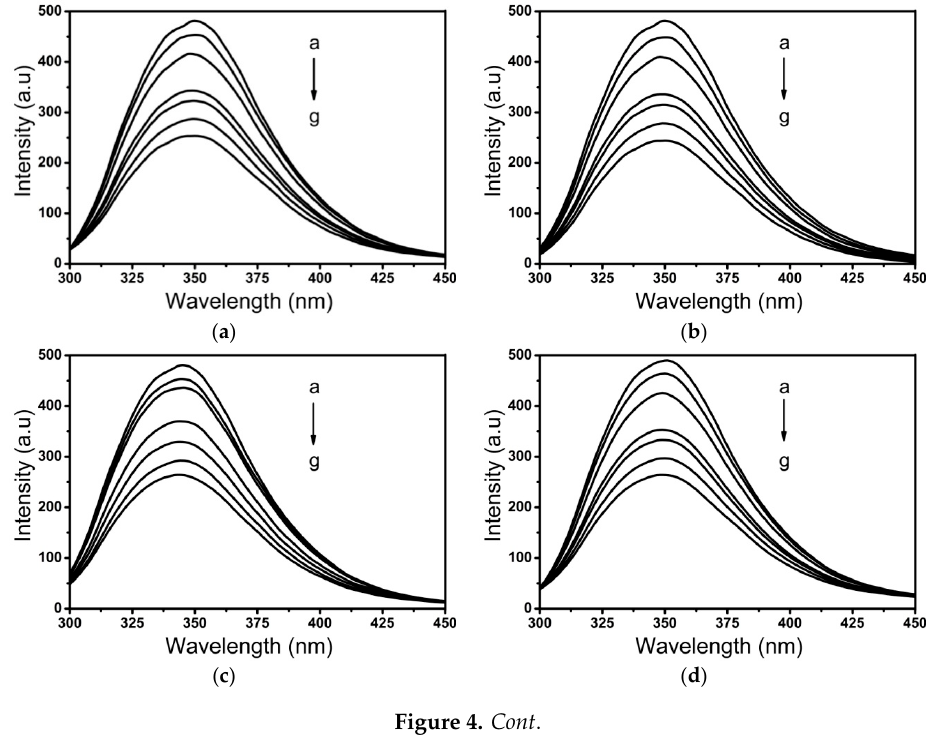
Table 1. Selected properties of the micellar systems studied. Experimental results represent the mean of 9 replicates ±